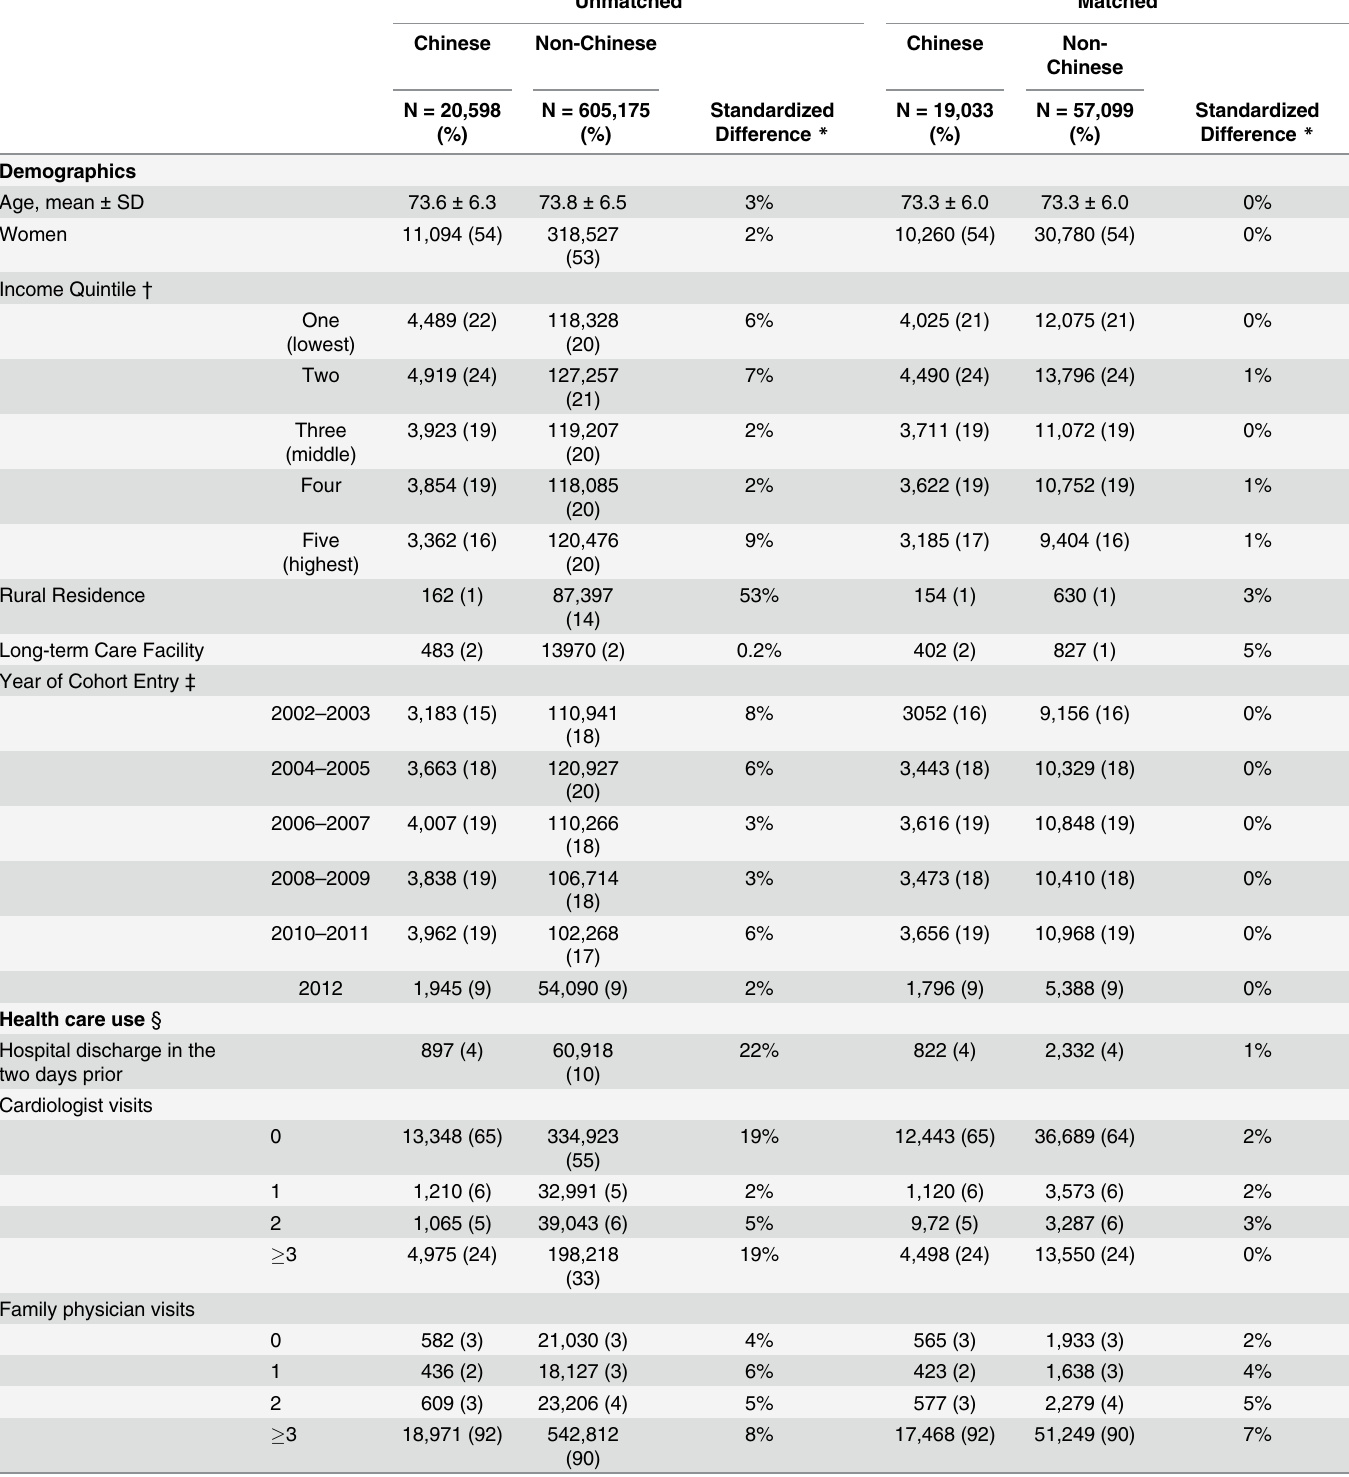
Table 1. Characteristics of Chinese and non-Chinese at cohort